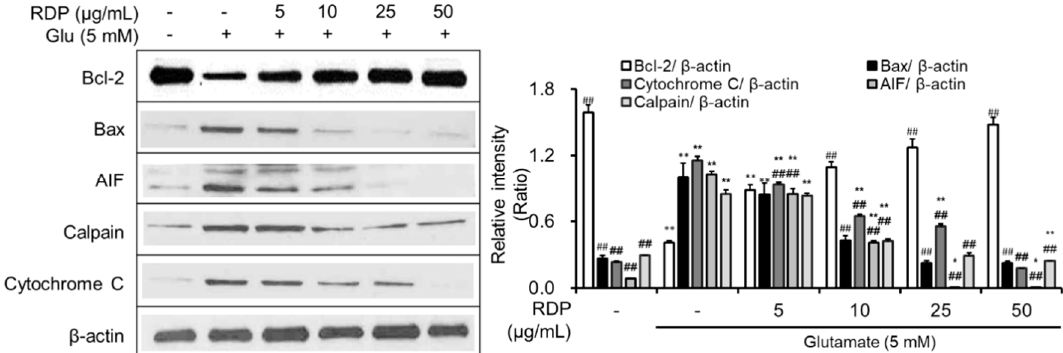
Figure 5. Anti-apoptotic effect of ethyl acetate extract of Ribes diacanthum Pall (RDP) on glutamate-induced apoptosis in HT-22 cells. HT-22 cells were seeded in a 60 mm dish and then incubated for 24 h. The cells were challenged with glutamate after pre-incubation with or without RDP (0–50 µ g / mL) for 30 min. After twelve h, the expression of Bcl-2, Bax, AIF, calpain. cytochrome c, and β -actin was measured. The data are obtained from three independent experiments. * p < 0.05 and ** p < 0.01 versus vehicle control group. ## p < 0.01 versus glutamate-treated group–indicates absence.